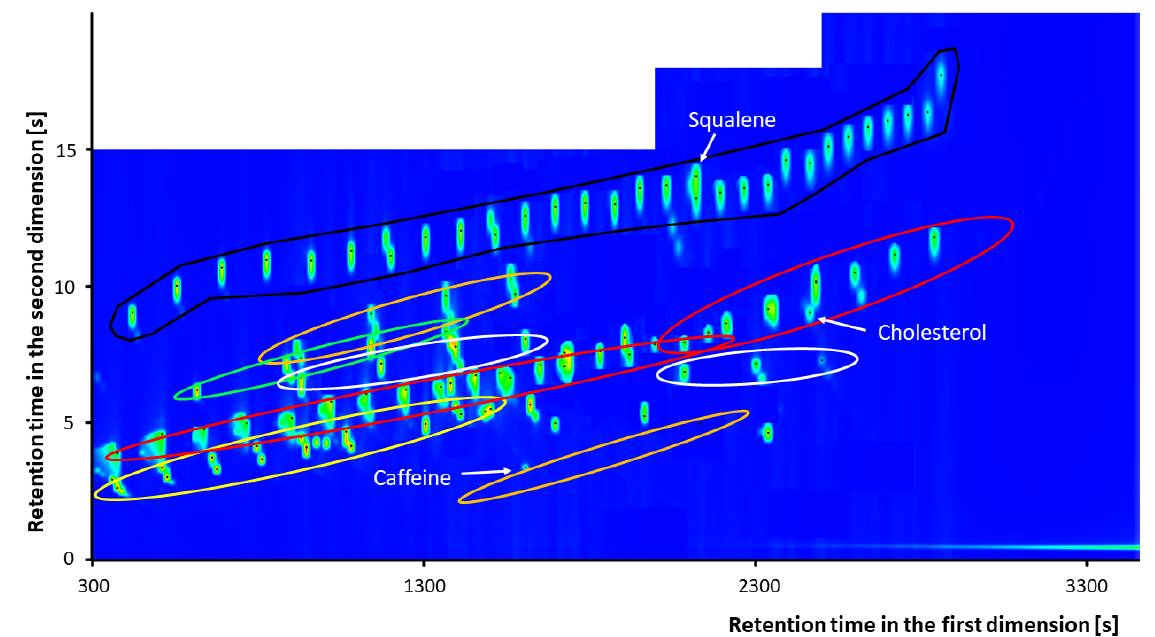
Figure 10. The TIC 2D chromatogram of the model mixture (composition see Table 1) measured under the conditions described in Section 2.4 on Rxi-200 MS (2 + 15 m) and TG-5HT (1 m) columns. The marked classification zones are the following: black ( n -alkanes), lower dark yellow (amines), upper dark yellow (amides), green (chloroalkanes), left white (alcohols), right white (ethers), yellow (aldehydes and ketones), left red (acids and esters), right red (esters of higher fatty acids), and unlabeled